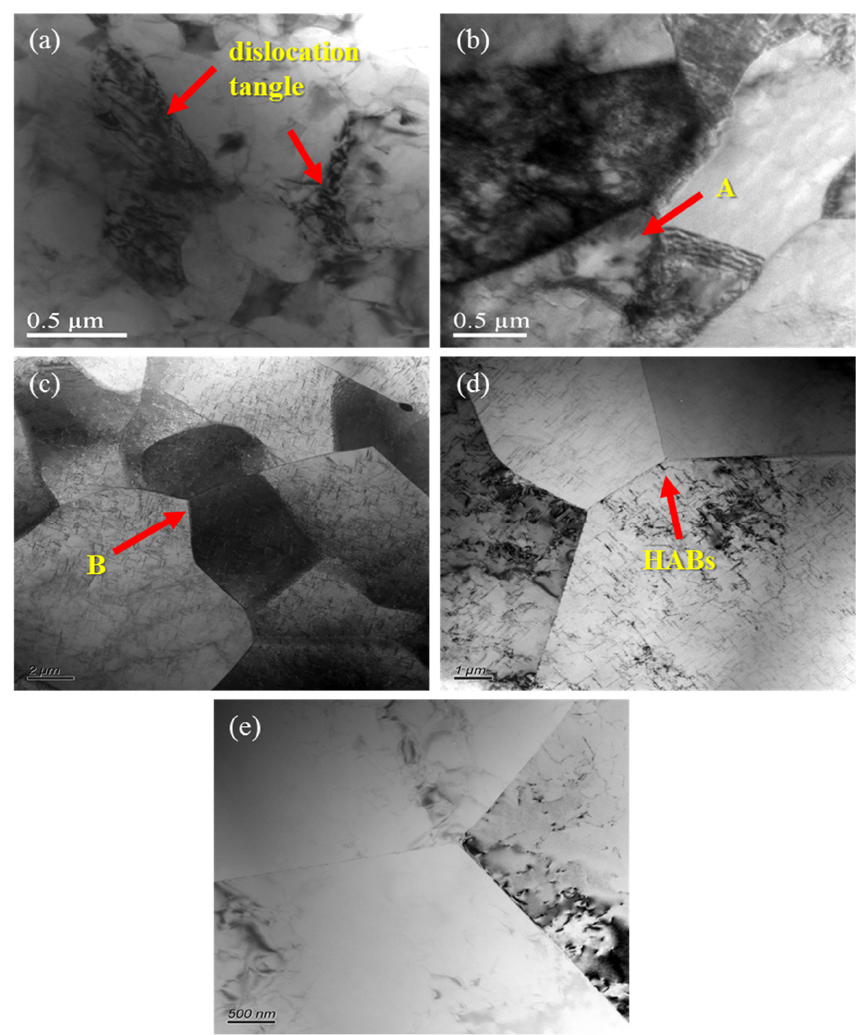
Figure 8. TEM deformed structures of the alloy at different temperatures and strain rates: ( a ) 300 °C/10 s −1 , lnZ = 49.44; ( b ) 360 °C/1 s −1 , lnZ = 42.67; ( c ) 420 °C/1 s −1 , lnZ = 38.97; ( d ) 480 °C/0.01 s −1 , lnZ = 31.26; ( e ) 540 °C/0.01 s −1 , lnZ = 28.61.